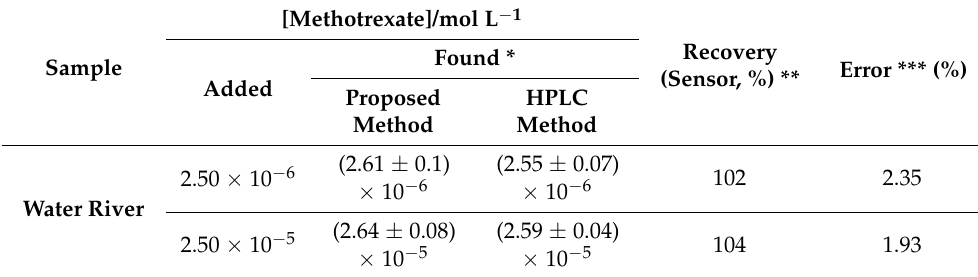
Table 2. Results obtained from the analysis of river water samples.